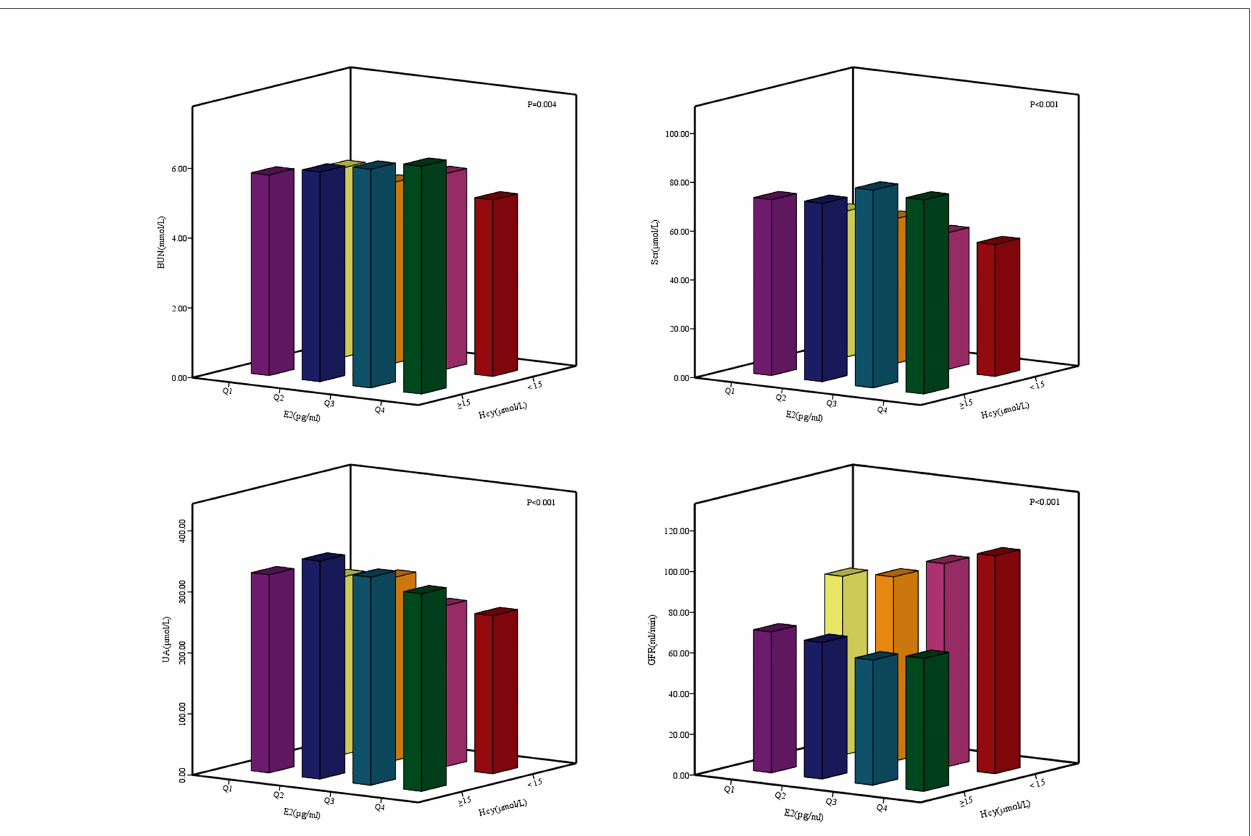
FIGURE 1 | Differences of renal function indexes BUN, Ser, UA, GFR between different E2 and Hey levels groups. E2: Q1: ≤ 4.99 pg/ml; Q2: 4.99 pg/ml - 14.95 pg/ ml; Q3: 14.95 pg/ml - 26.80 pg/ml; Q4: > 26.80